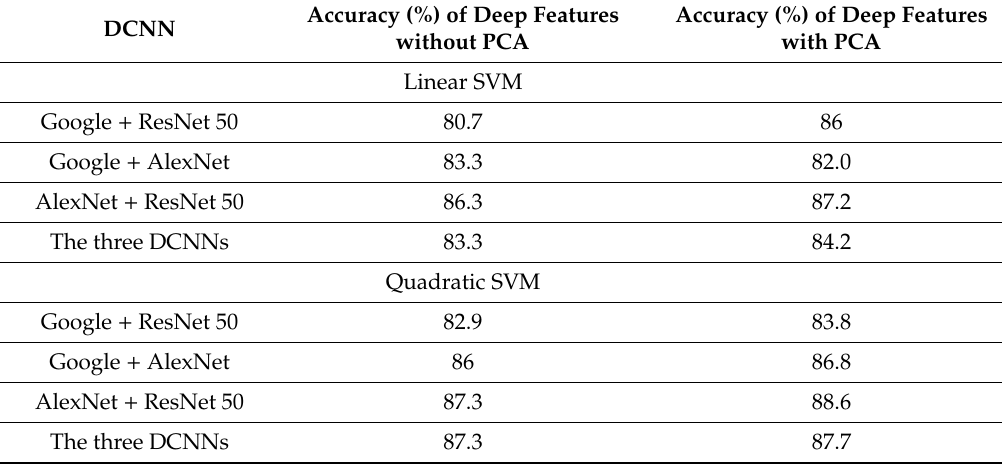
Table 6. A comparison between the accuracies of the linear SVM classifier trained with several deep features extracted from different DCNNs. features extracted from di ff erent